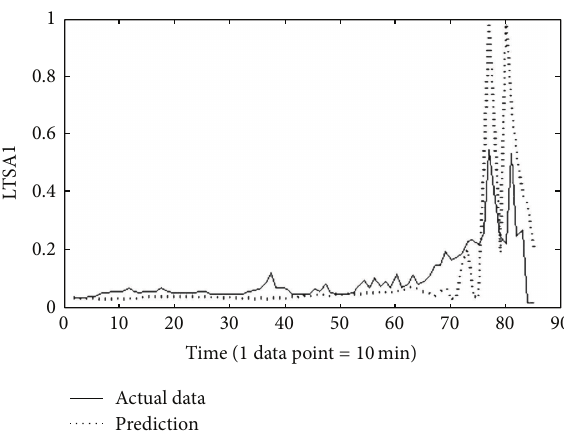
Figure 11: Prediction result based on the SVM model.